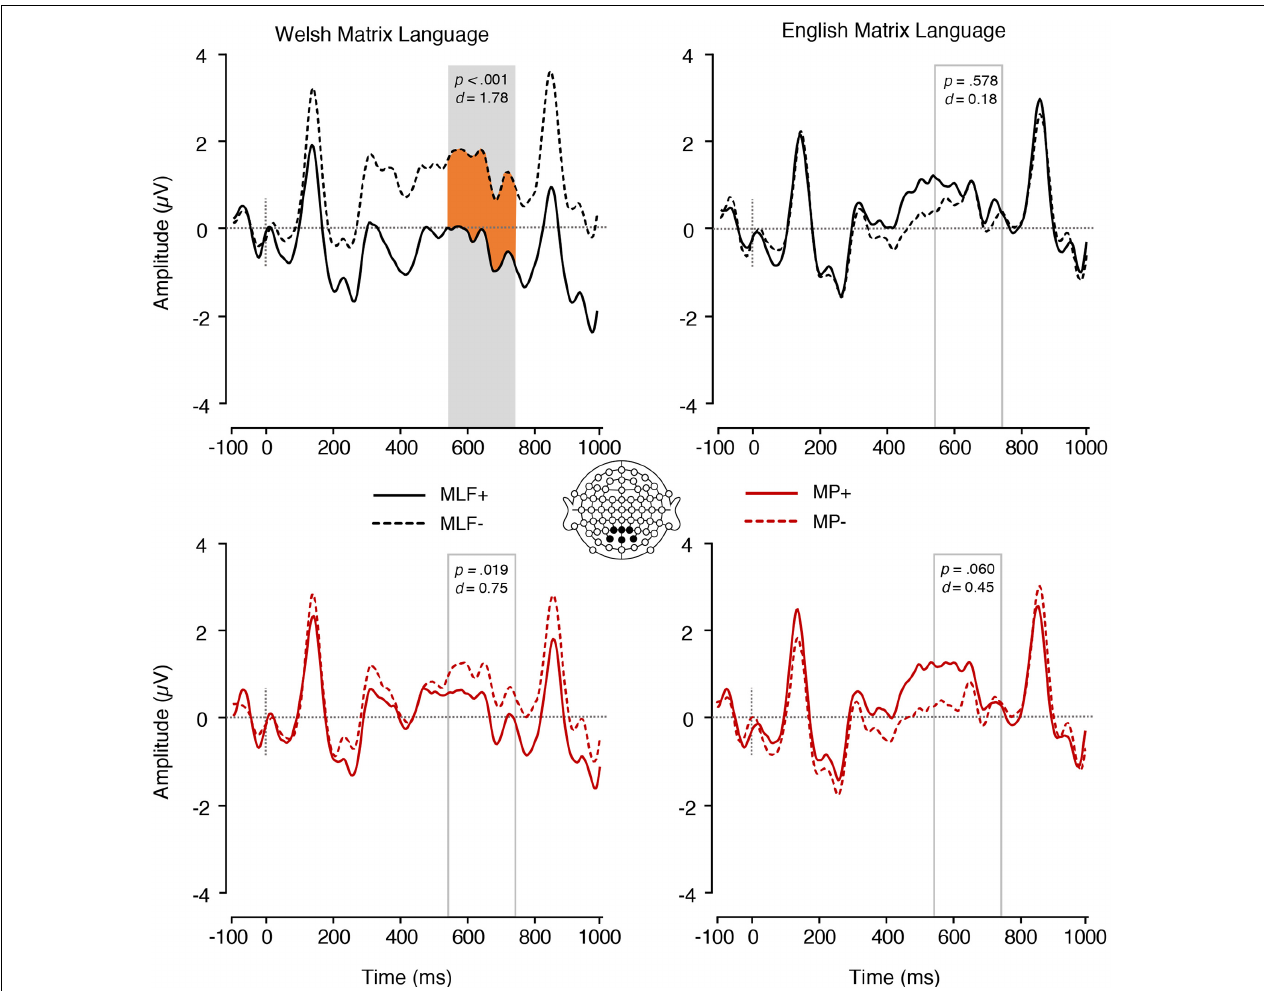
FIGURE 7 | ERPs elicited by adjectives depicting the Matrix language ∗ MLF and the Matrix language ∗ MP interactions. The plain grey box indicates the time window of the analysis in which mean ERP amplitudes significantly differed between conditions (550–750 ms post-stimulus). MLF, Matrix Language Framework; MP, Minimalist Programme; +, stimuli compliant with prediction; –, stimulus violating